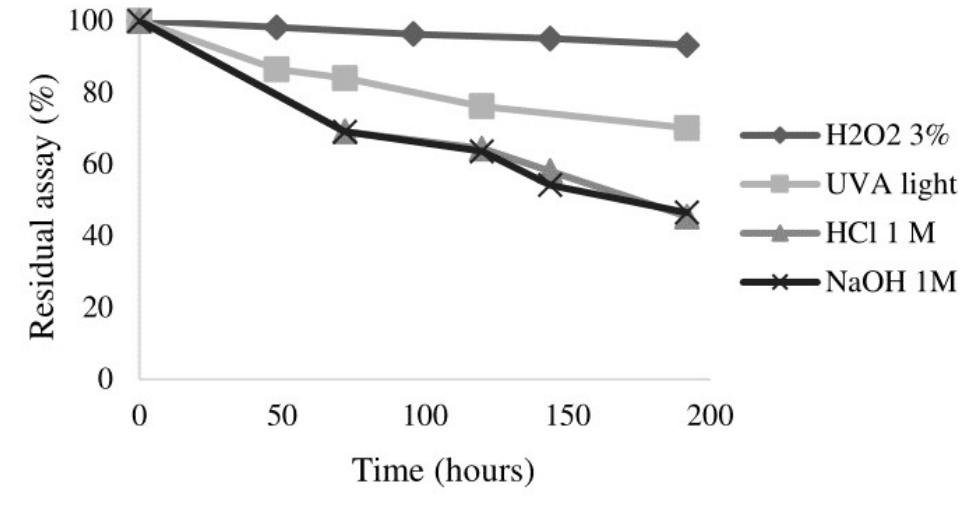
FIGURE 3 – Empagliflozin solutions stability on stress test evaluated on an 8-day